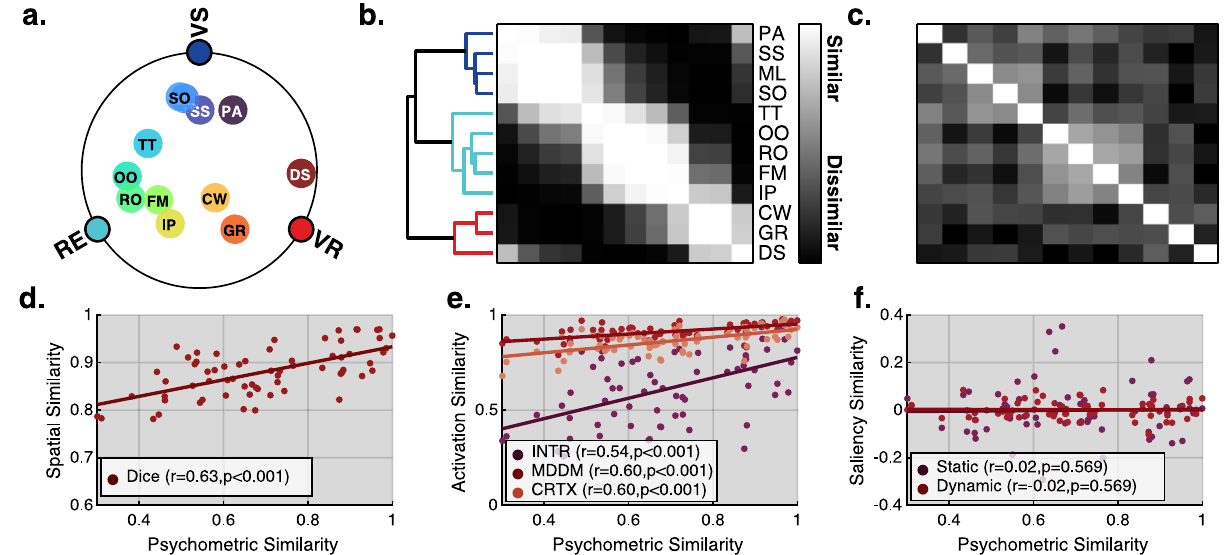
Fig. 3 Distributed activation pattern correlates with behavioural similarity. a A previously published internet-based study using test scores from >60k members of the general public was used to de fi ne the psychometric similarity between the 12 tasks 2,7 . Loadings from the three-factor solution are presented using a radial projection where each pole represents one of the following factors (VS — visuospatial, RE — reasoning, VR — verbal reasoning). The initials for each task are displayed (see Fig. 1 for reference and Supplementary methods A.1 for a description of each task). b Hierarchical cluster analysis of the 66-paired psychometric similarities further re fl ects the pairwise similarity between tasks. The three-factor structure is clearly evident as clusters of higher correlation proximal to the lead diagonal. c DICE coef fi cients from each pair of whole-brain group-level task activation maps. d – f The following scatter plots test association between psychometric similarities and different sources of similarities using a right-tailed Pearson correlation coef fi cient test. When applicable tests are FDR corrected. d A strong positive correlation ( p = 6.82e − 09) was observed between task psychometric similarities and spatial activation DICE coef fi cients, i.e., tasks that activate the same regions are more proximal in the behavioural factor space. e Cross-correlation pairwise similarity extracted from activation patterns within each of the three ROI sets (cortex — CRTX ( p = 1.6e − 06), Multiple-demand default mode — MDDM ( p = 8e − 08), Int e rsection — INTR ( p = 8e − 08)) showed a strong positive correlation with psychometric similarity (see similarity matrices in Fig. 2f). f No signi fi cant correlation was observed between task psychometric similarities and similarities in salience time courses (see Supplementary methods A.4). This indicates that the association between brain activation patterns and psychometric similarity is not driven by temporal similarities of stimuli presentation and motor sequencing across the tasks. Source data are provided as a Source Data fi